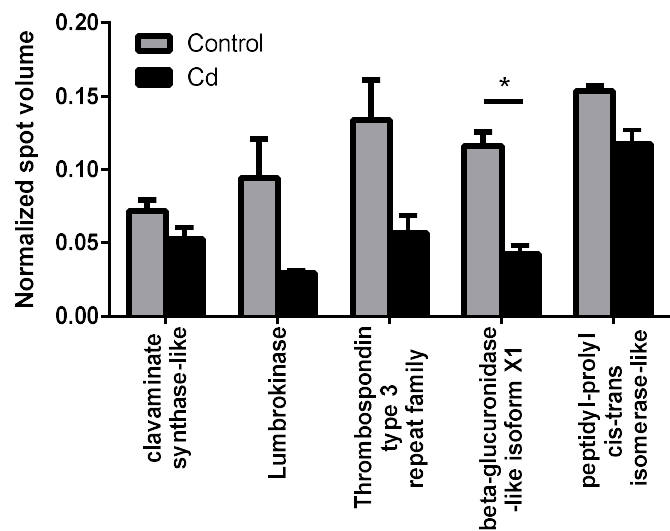
Figure 1. Immunity-related proteins, which were detected in the proteomics approach in controls and after two weeks of Cd exposure (50 mg/kg dry soil). * t -test indicates significant differences at p ≤ 0.05.